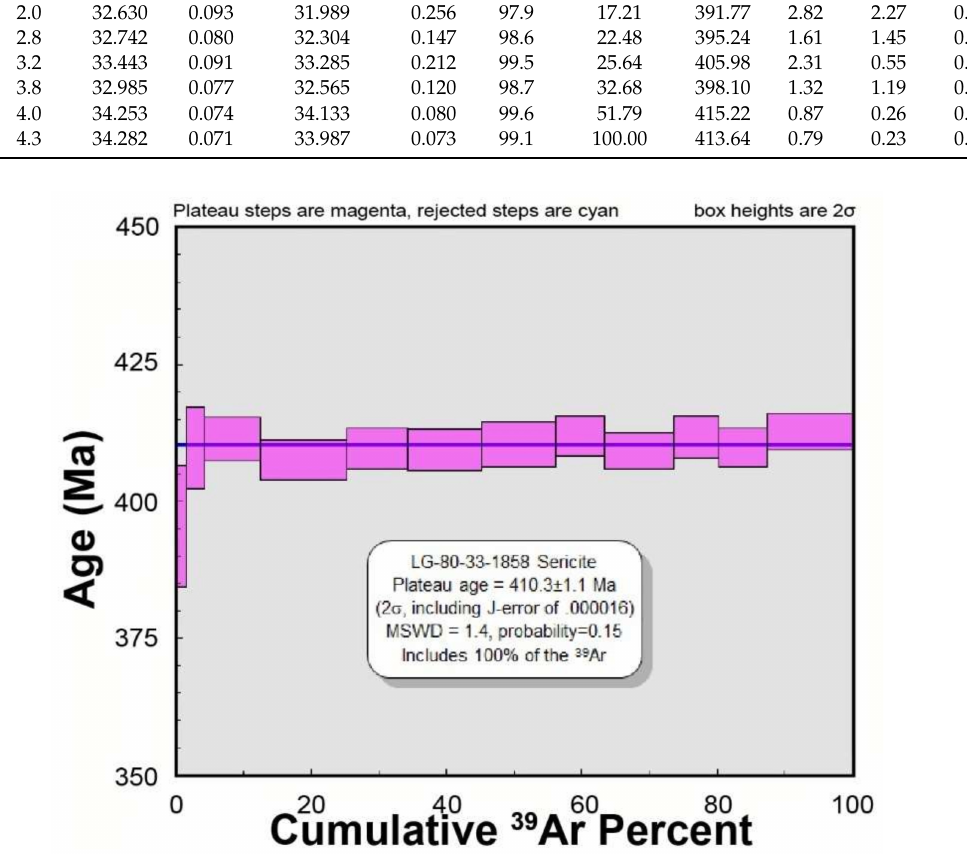
Figure 19. 40 Ar / 39 Ar age spectrum of muscovite separate from the sericitic alteration surrounding the gold-bearing quartz–carbonate vein from drill core sample LG-80-33-1848 (563.3